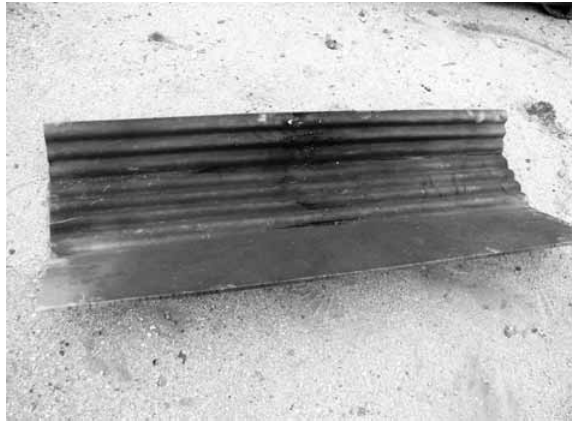
Fig. 24. Inside view of thick shield after test.